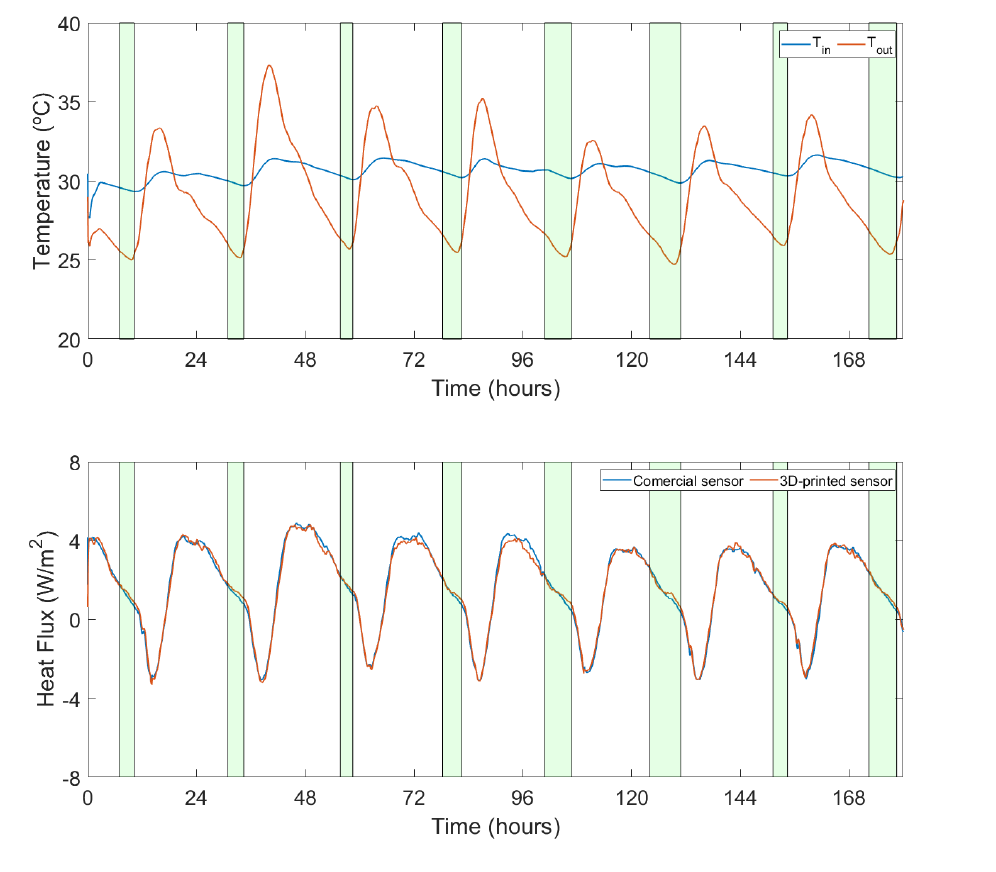
Figure 17. Evaluation of the U-value of an exterior masonry brick wall for five